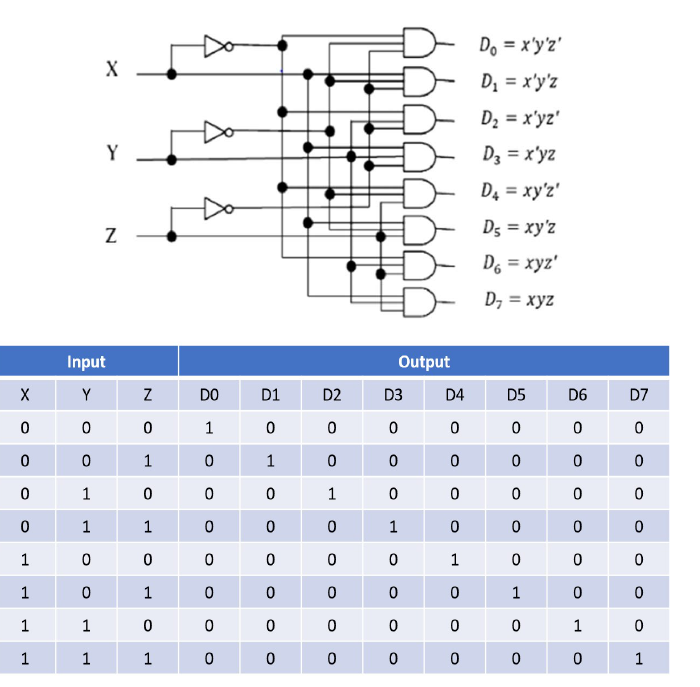
Figure 5. 3-8 multiplexer model with its truth table. Reproduced with permissions from [35].